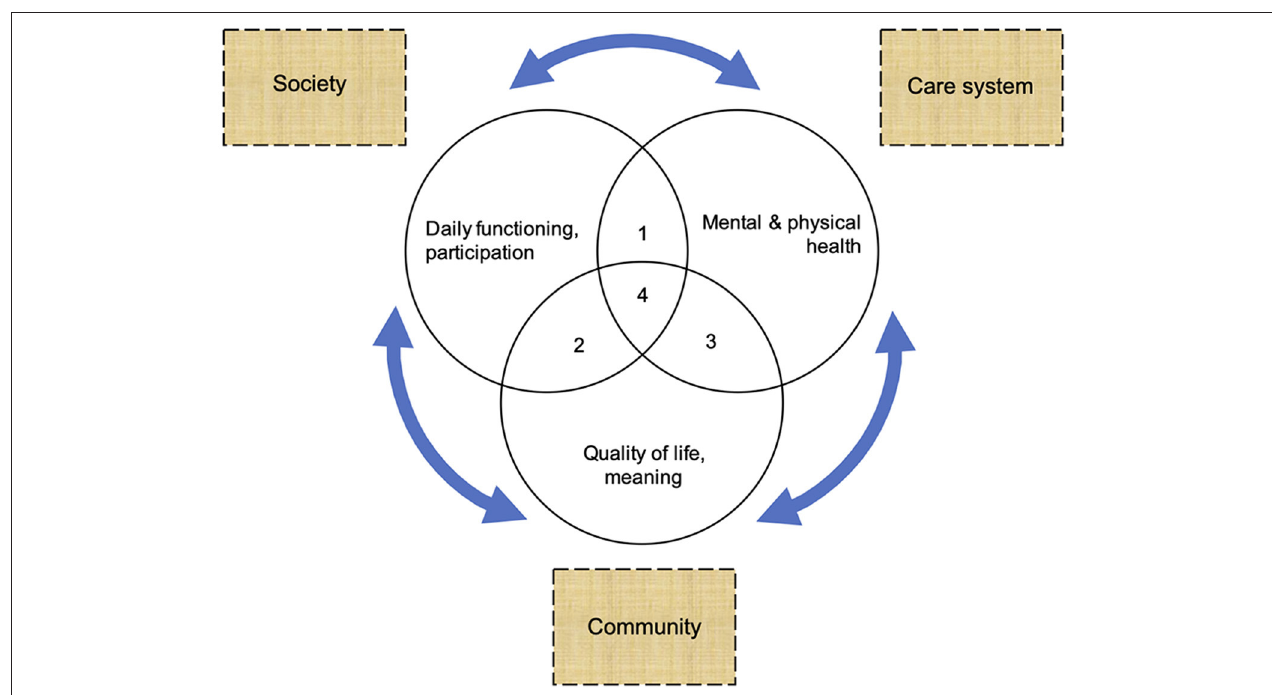
FIGURE 3 | Comprehensive assessment of symptomatic, social, and personal dimensions and conditions to enable